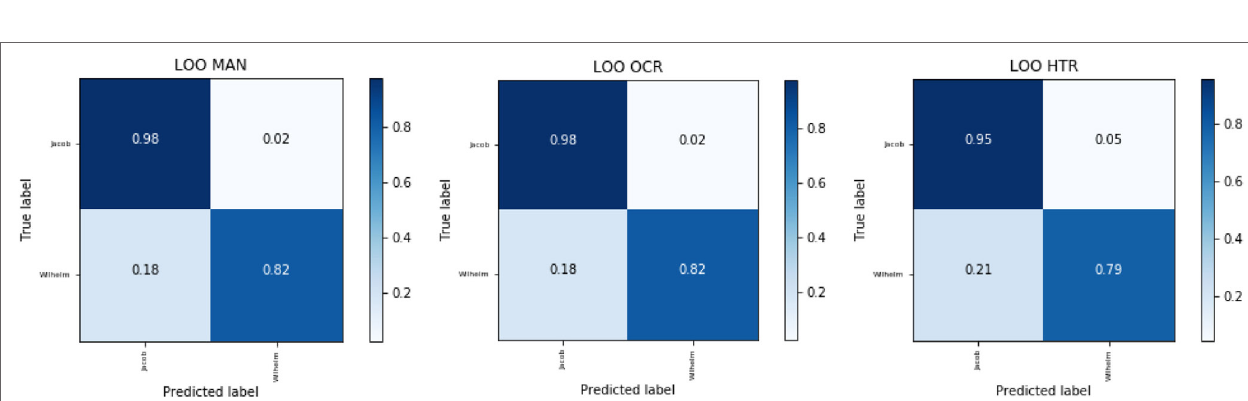
FigUre 7 | General information about the subcorpus in this section: distribution of letters in terms of chronology, length, and authorship